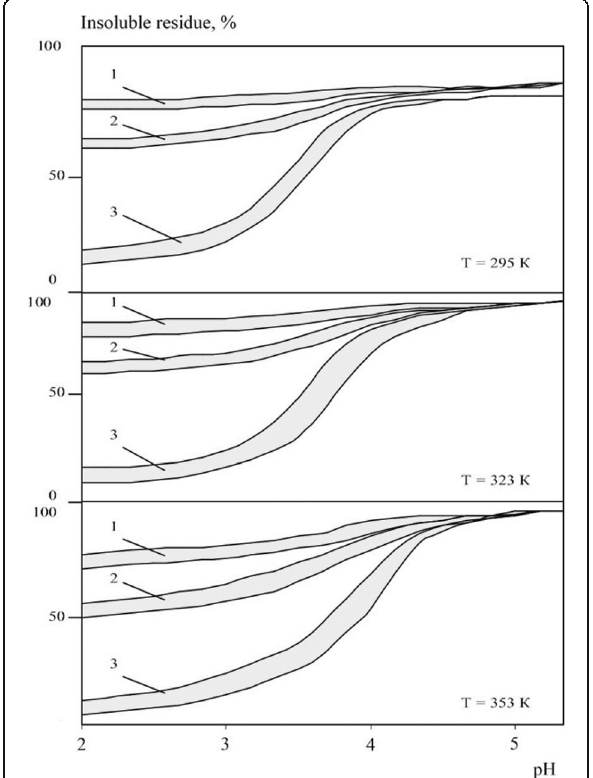
Fig. 1 Insoluble residues ratios areas for nanopowders of borides of zirconium, titanium, vanadium, chromium, molybdenum, and tungsten in electrolytes solutions of different acidity depending on the temperature and exposure time τ = 1 – 3 h, 2 – 24 h, 3 – 240